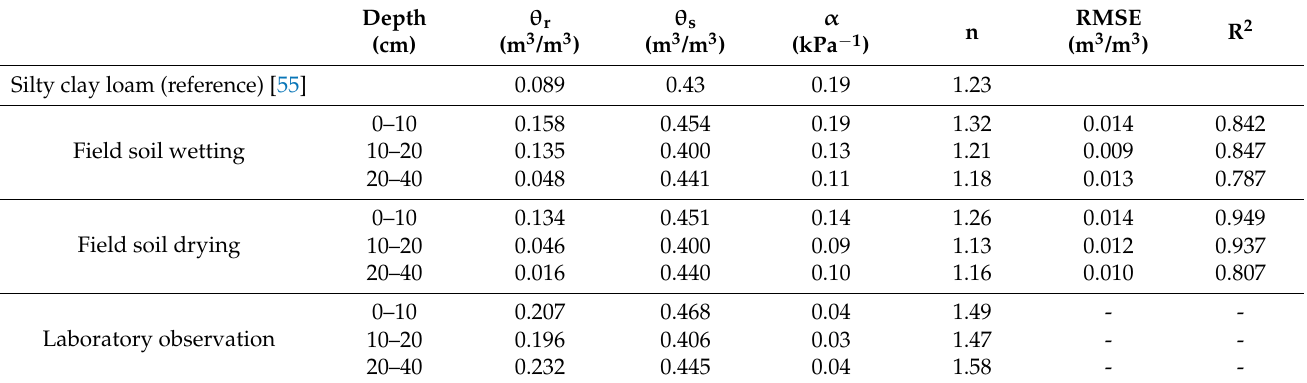
Table 2. Field and laboratory parameter inversion results and fitness